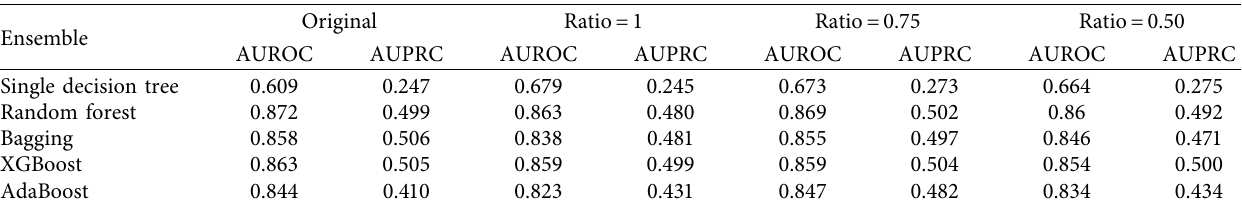
Table 3: The performance of the Standard decision tree ensembles with the SMOTE oversampling method for different ratios of minority and majority class points. AUROC and AUPRC performance measures are used in the experiments. Bold numbers show the best results.